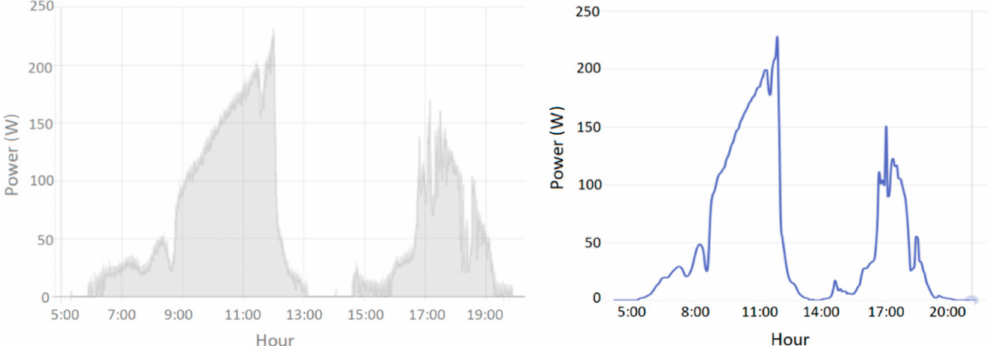
Figure 15. Power graph of 21 July 2019 (SmartPV—left side, inverter—right